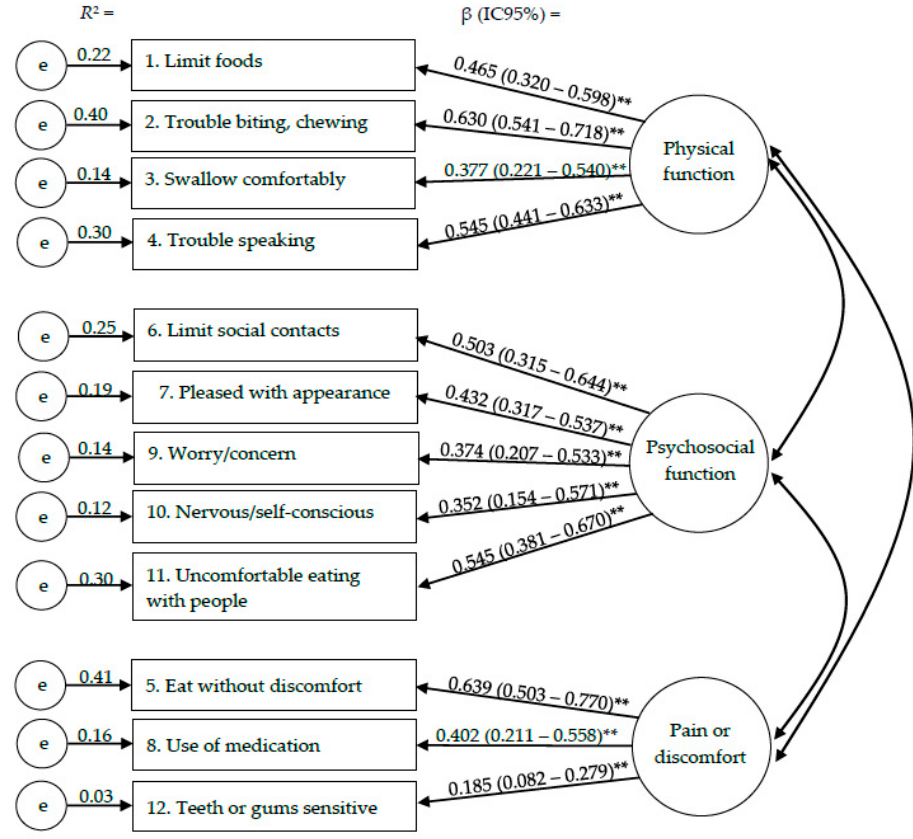
Figure 1. Confirmatory factor analysis of the three-factor and twelve-item measurement model obtained through bootstrap item loadings (standard error/bias-corrected 95% CI). ** p < 0.01. The GOHAI inter-item correlations varied from 0.047 (between item 10 and item 12) to 0.442 (between item 2 and item 5). GOHAI item–dimensions correlations ranged between 0.162 (between item 12 and the physical function dimension) and 0.809 (between item 12 and the pain or discomfort dimension) (Table